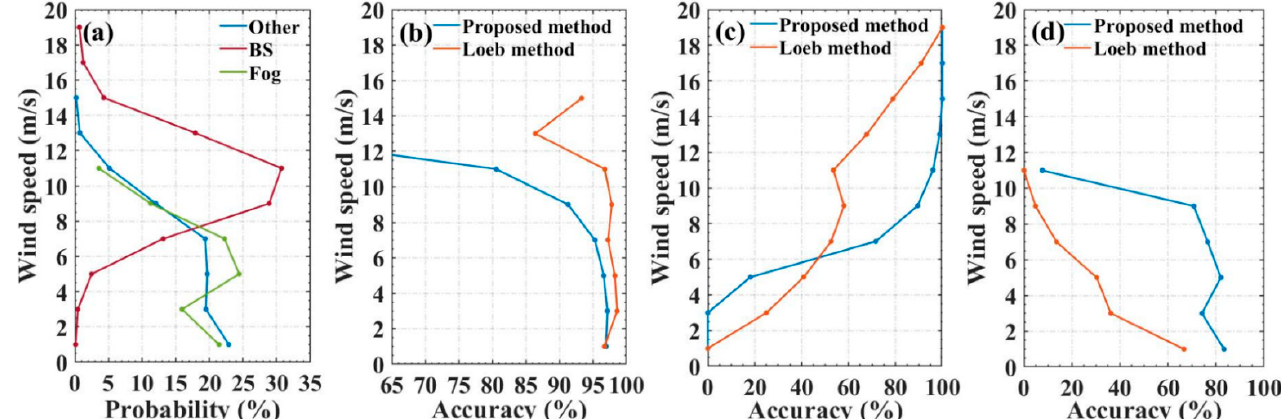
Figure 6. ( a ) The distribution proportion of other situations, blowing snow and fog under different wind speeds. The accuracy of the proposed algorithm and Loeb method for classifying ( b ) other situations, ( c ) blowing snow and ( d ) fog under different wind speeds.